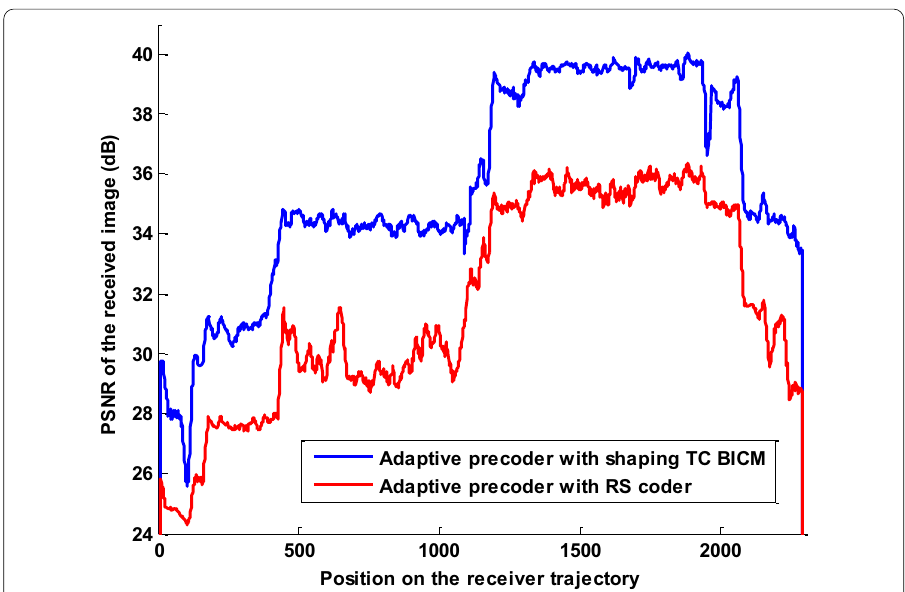
Fig. 13 PSNR for the Monarch image. A PSNR comparison for the Monarch image between the proposed scheme and the one presented in [12] through the reception